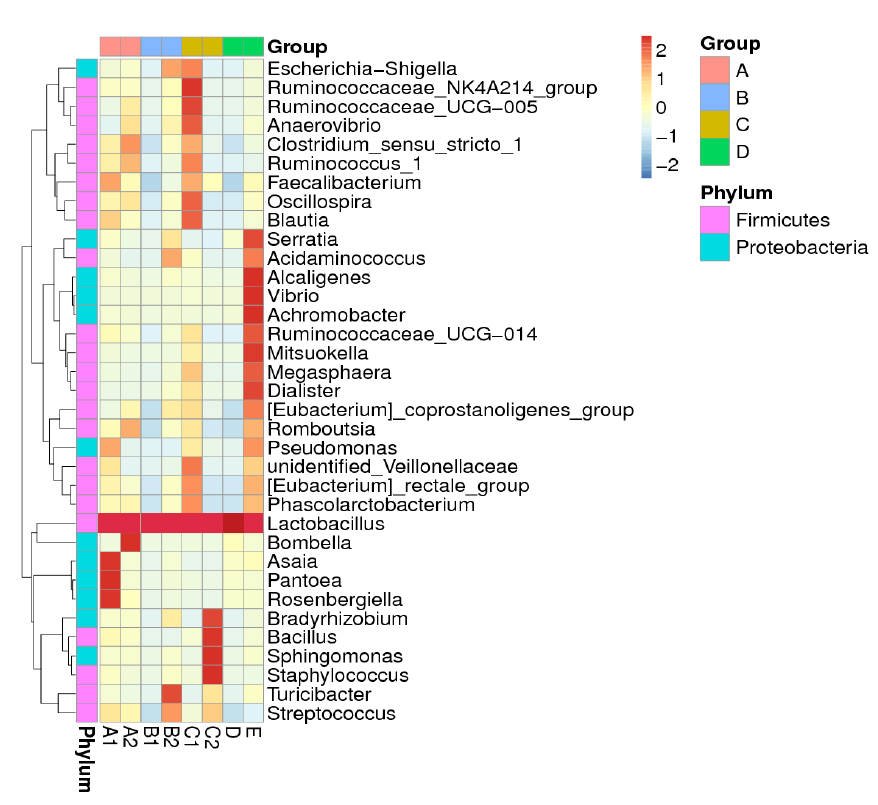
Figure 2. Heatmap showing 35 bacterial genus of stingless bee honey with significant di ff erences in abundances between groups (Kruskal–Wallis test, df = 3, FDR-corrected p < 0.05). Based on the relative abundance of OTUs, a phylogeny-based weighted Unifrac principle coordinate analysis, PCoA (Figure 3) showed no clustering points, which indicates the dissimilarity and wide di ff erence in bacterial community among all samples of both same and di ff erent stingless bee genera. Therefore, the type of bacterial community present in stingless bee honey is not influenced by the stingless bee taxonomic group up to genus level.